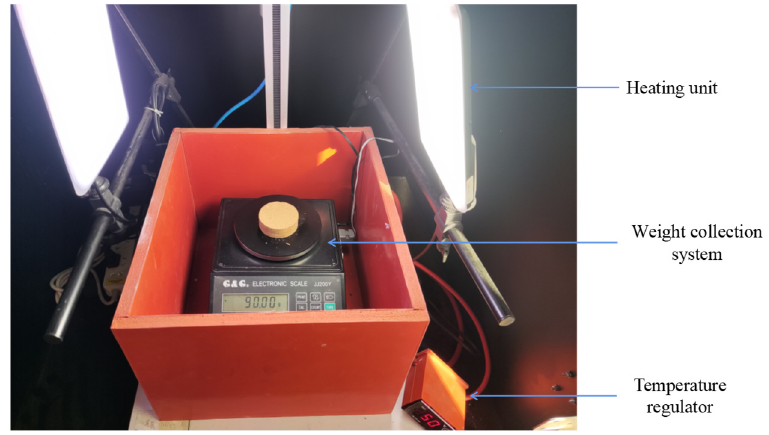
Figure 3. Thermostatic box.